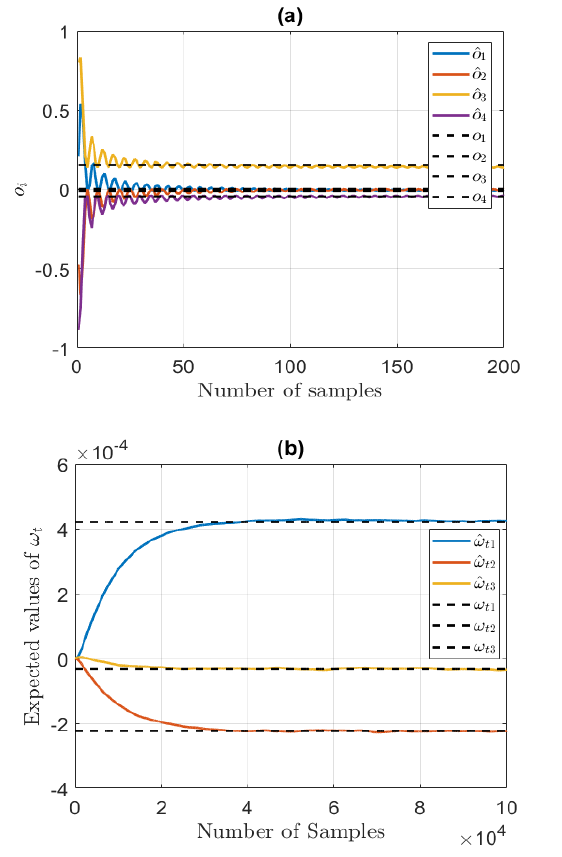
Figure 7. The convergence behavior of channel mismatch coefficients: (a) offset, (b) timing.